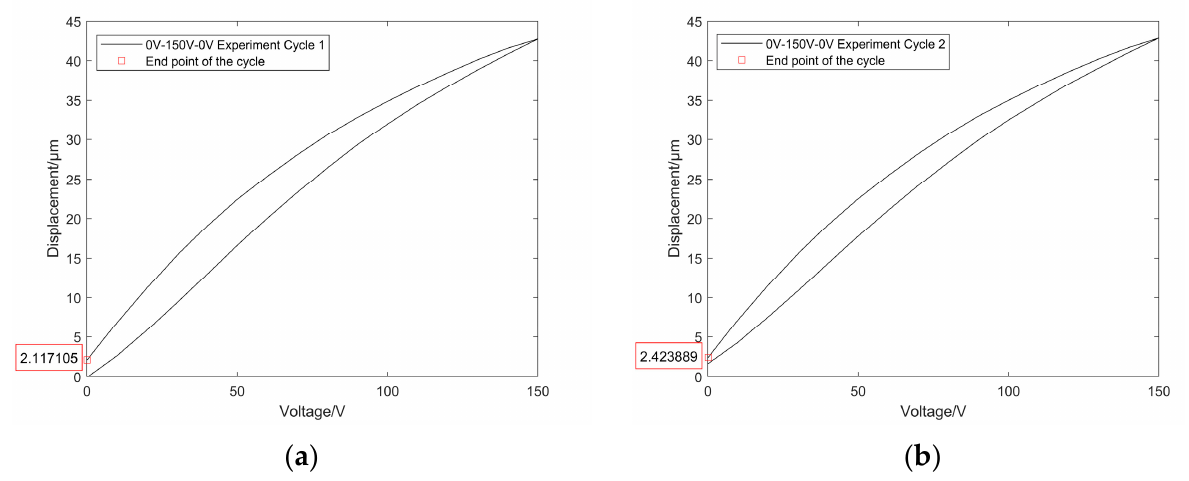
Figure 6. Start-up error diagram: ( a ) start-up first cycle error; ( b ) the second cycle. Three sets of test experiments at different voltages were tested. The initial drive voltage of the piezoelectric ceramic actuator is 0 V. The linear voltages of 0–150–0 V, 0–100–0 V, and 0–50–0 V are given, respectively. As shown in Table 1, the start-up error values for the three sets of test experiments are shown. Table 1. Start-up error values at different given voltages.